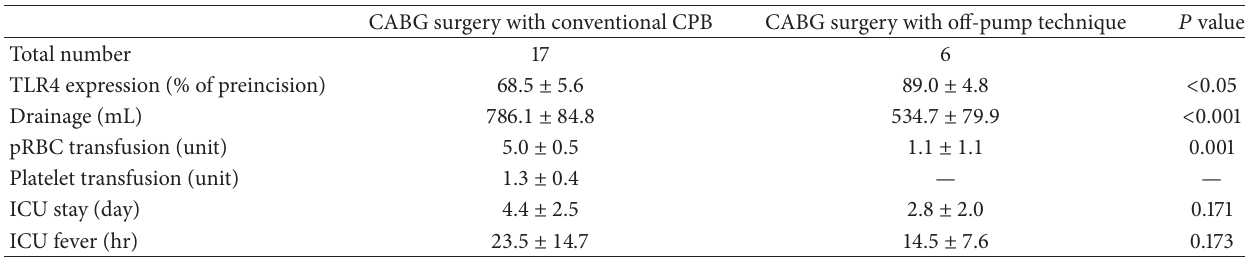
Table 4: TLR4 expression, drainage, duration of ICU stay, and duration of fever in CABG surgery patients. CABG surgery with conventional CPB CABG surgery with off-pump